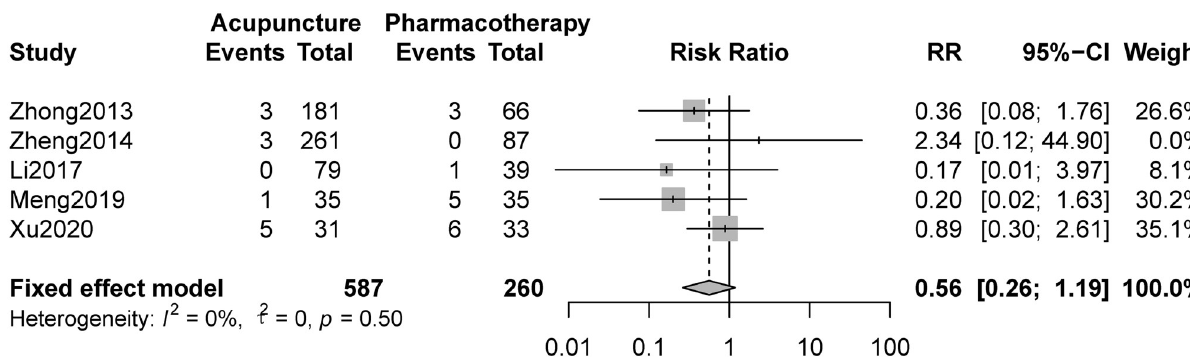
PLOS ONE | https://doi.org/10.1371/journal.pone.0263166 January 27, 2022 12 /